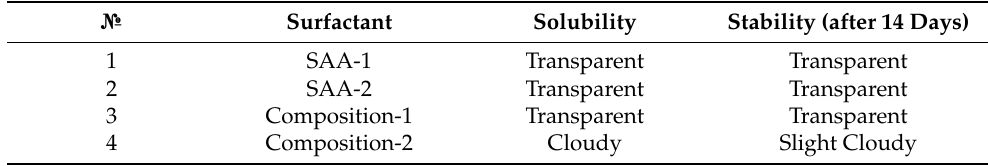
Table 4. Results of tests for solubility and long-term stability. № Surfactant Solubility Stability (after 14 Days) SAA-1 Transparent Transparent SAA-2 Transparent Transparent Composition-1 Transparent Transparent 4 Composition-2 Cloudy Slight Cloudy